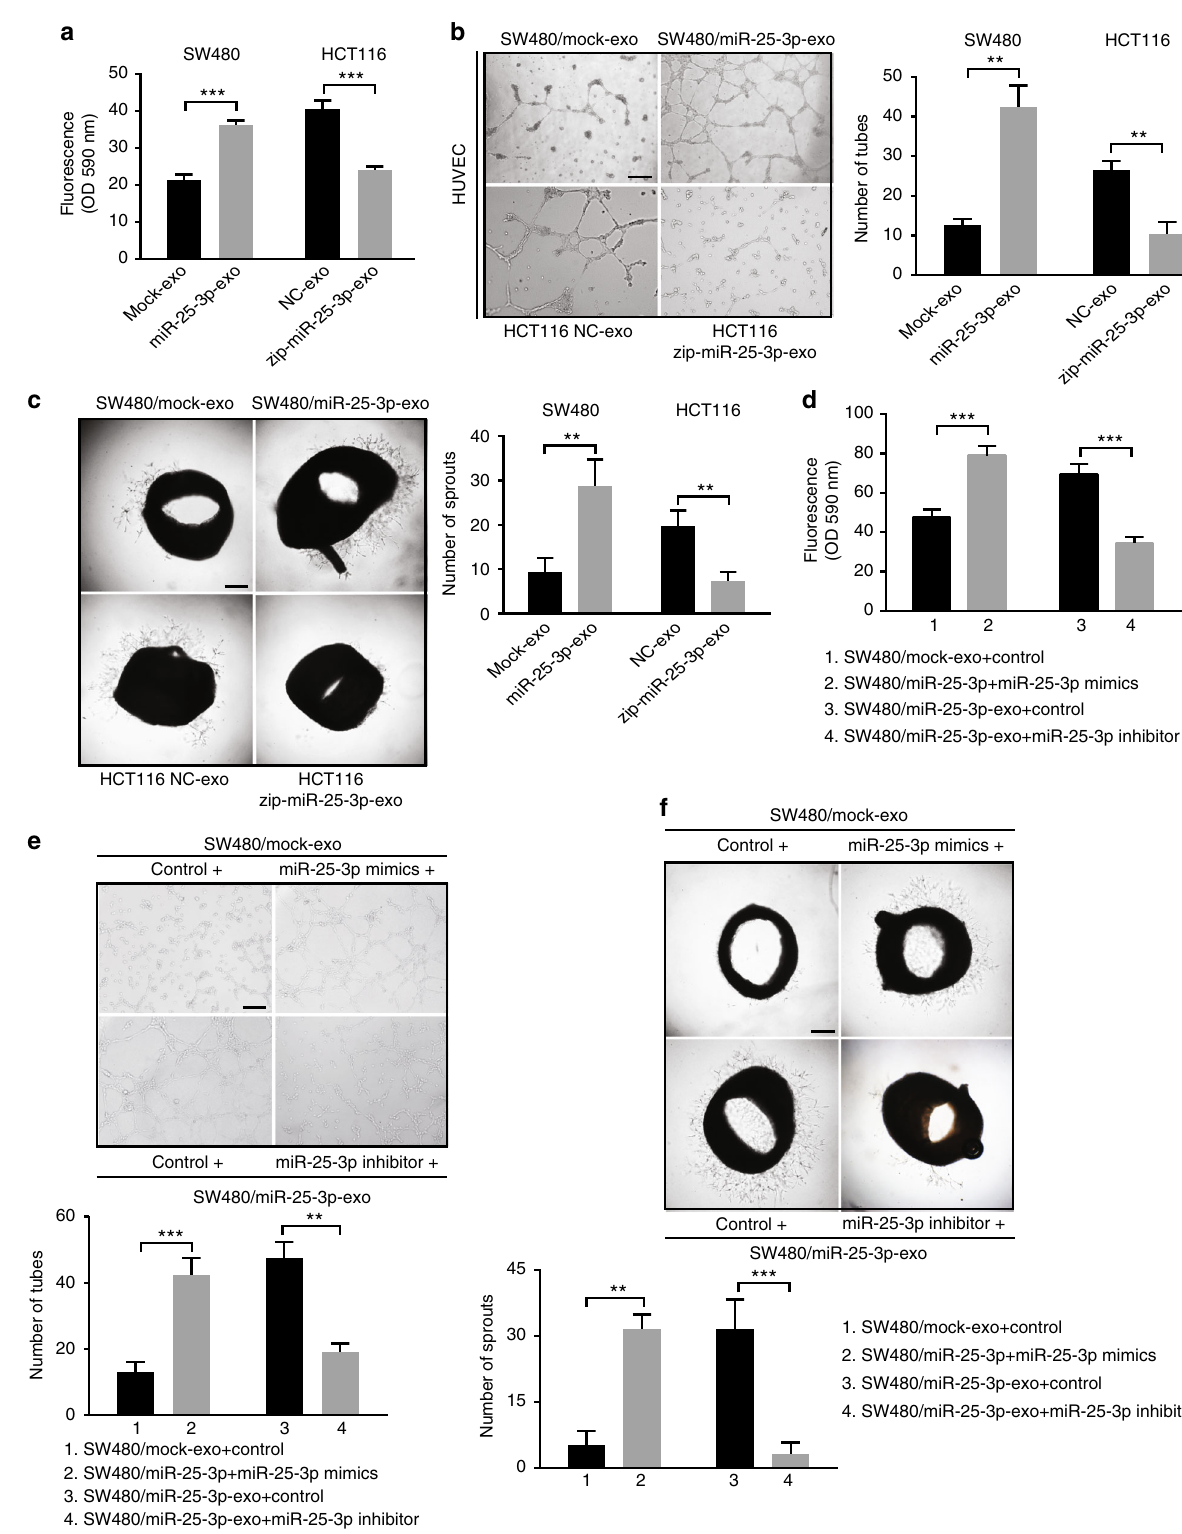
expression level of HIF α , suggesting that the angiogenic role of miR-25-3p was independent of HIF α (Supplementary Figure 9A). Furthermore, a dramatically lower vascular permeability was observed in the liver and lung from mice implanted with HCT116/zip-miR-25-3p cells in the pre-metastatic stage (Fig.